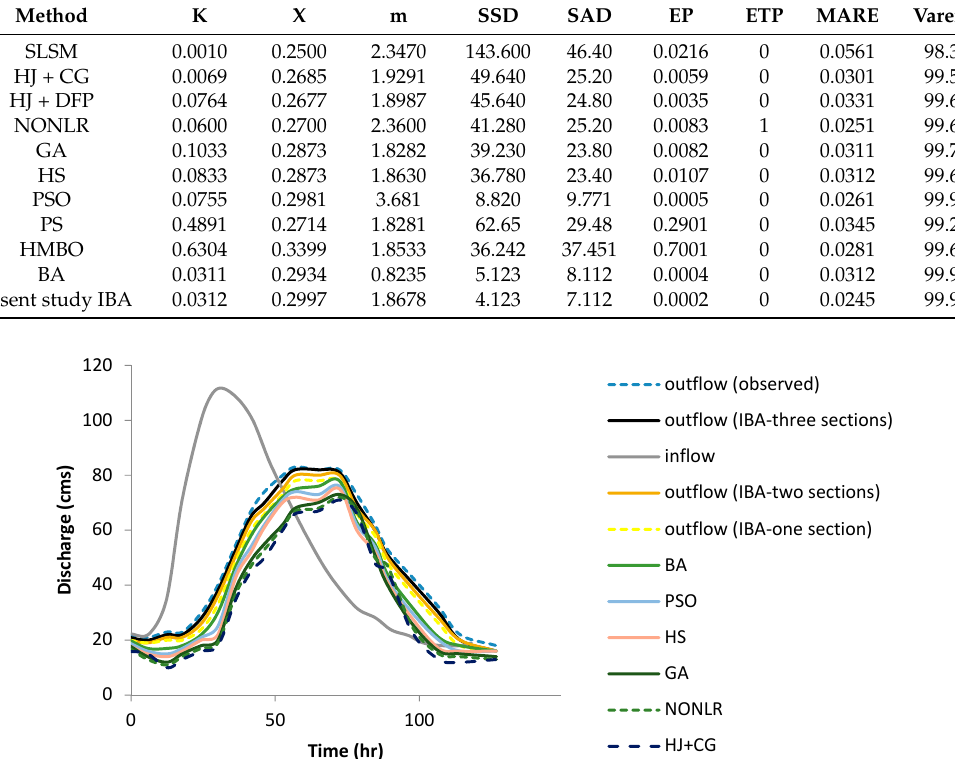
Table 4. Computed error indexes for Wilson flood.